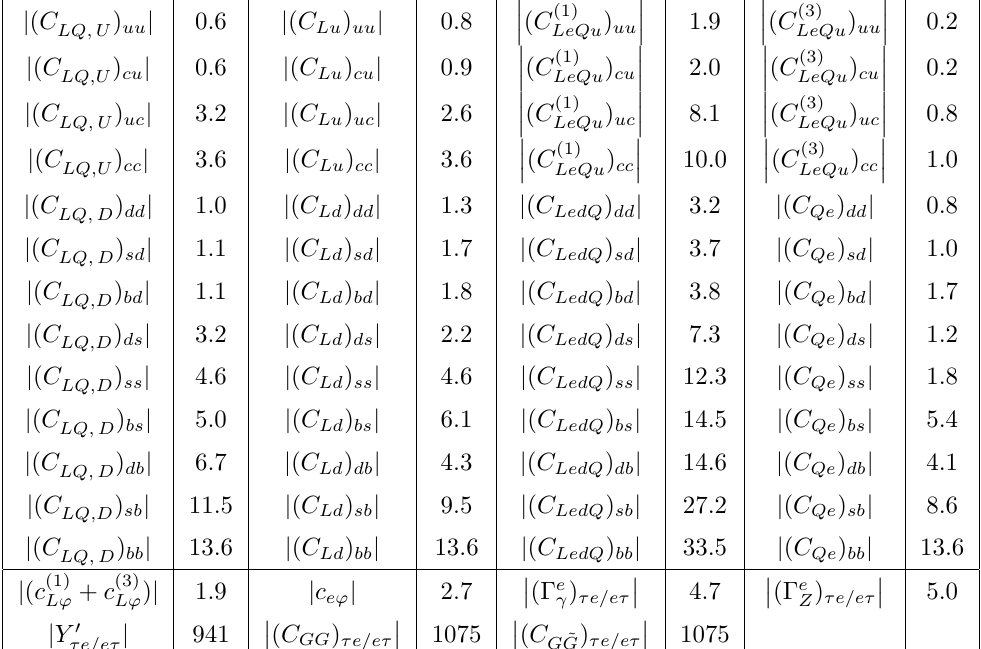
Table 7 . EIC sensitivity, in units of 10 − 2 , to CLFV operators at 90% CL with E e = 20 GeV , √ E p = 250 GeV ( S = 141 GeV) and L = 100 fb − 1 . Bounds on the right-handed operators C eu and C ed are almost the same as C LQ,U and C LQ,D